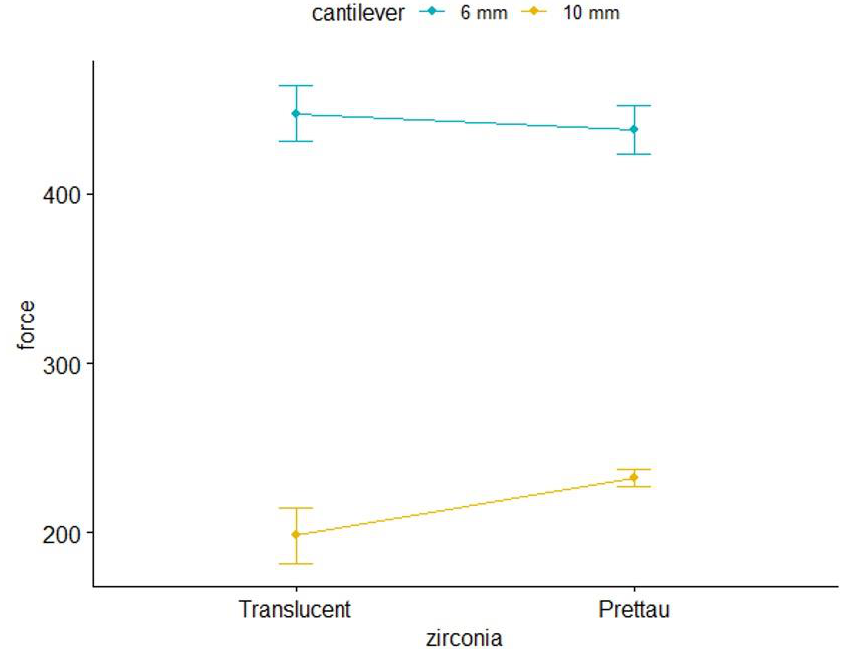
Figure 6. Force at break (standard) (N) interaction between type of zirconia and cantilever length. Table 5. Unilateral one-sample t -tests for assessing limits of force at break (standard) (N). Tests for Mean > 250